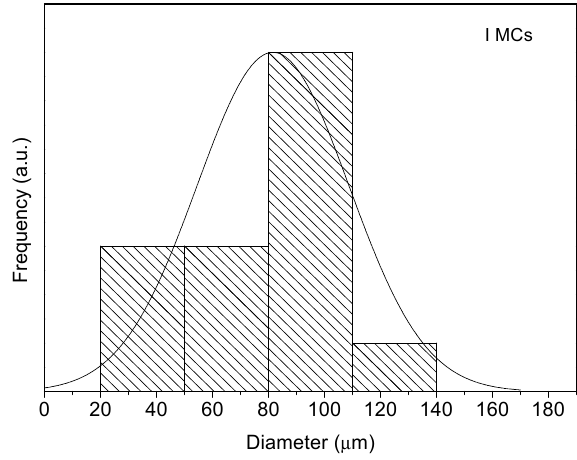
Figure 8. Size distribution of I MCs.